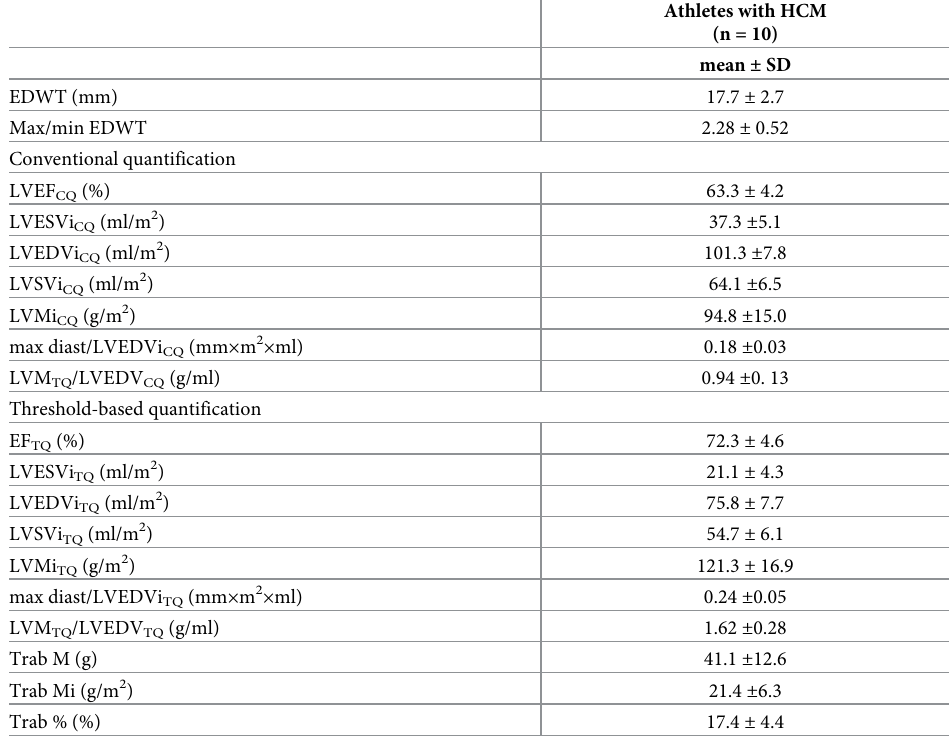
Table 1. Left ventricular CMR parameters of athletes with HCM using conventional (CQ) and threshold-based (TQ)